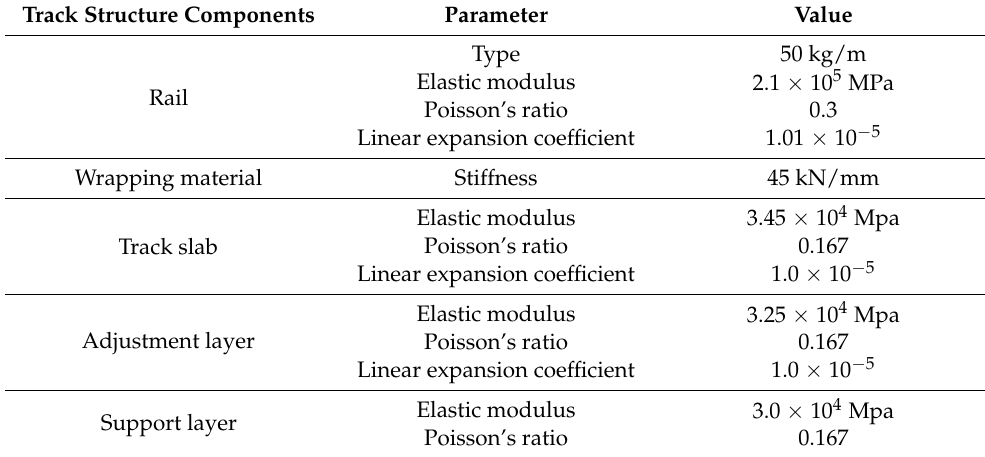
Table 1. Track structure